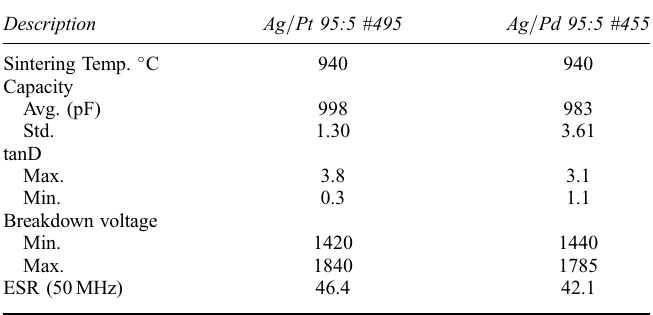
TABLE V Comparison of Electrical Performance of Powders #455 and #495 (95:5 Ag = Pt and Ag =